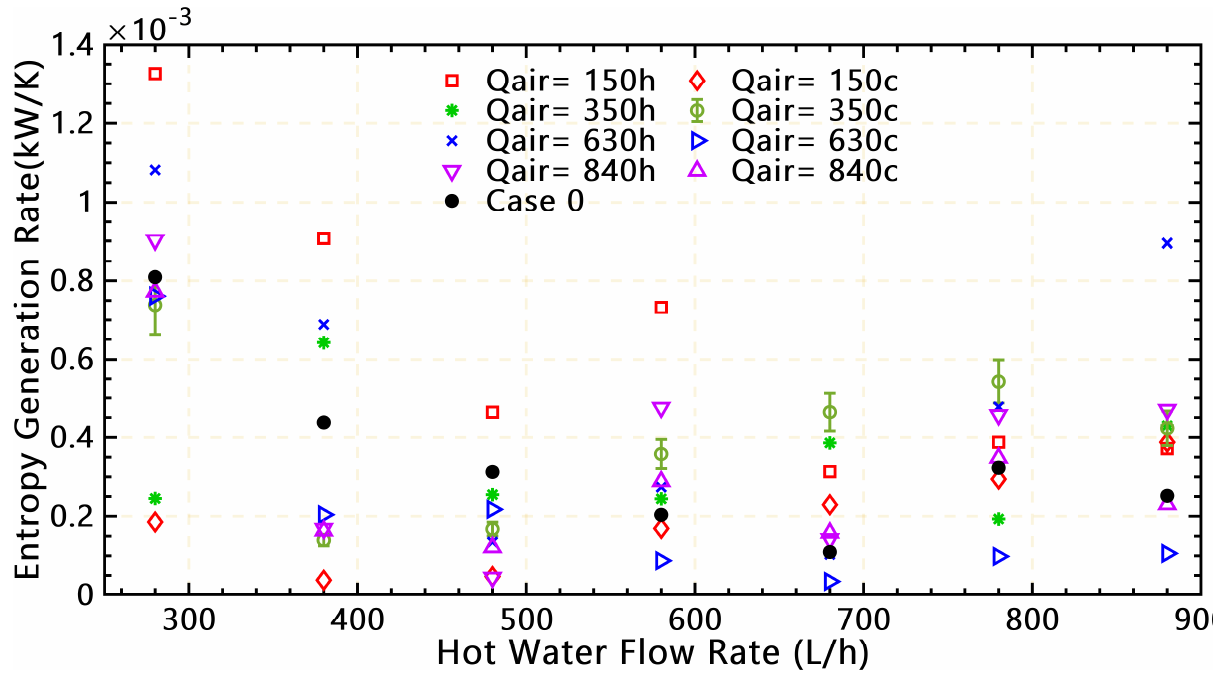
Figure 8. Variations between S gen and Q h for original case and different ABI of: CWS; HWS.